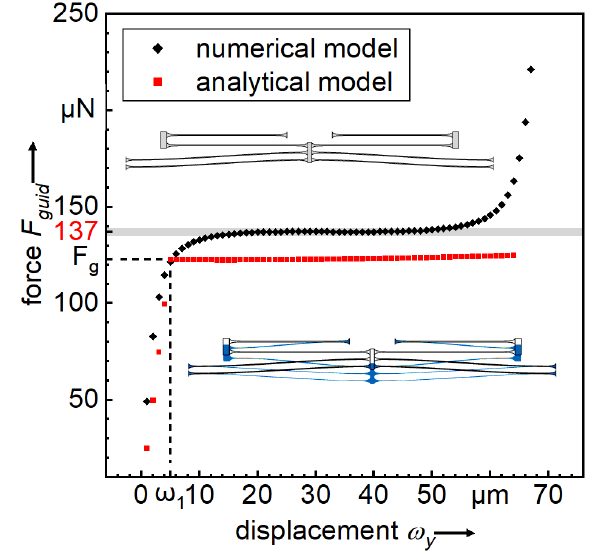
Figure 3. Simulation result of the constant force spring system consisting of one linear serpentine spring and two curved cosine-shaped buckling beams (shown above the graphs). The simulated maximal displaced spring system is pictured under the graphs. The following parameters were used for the analytical model: E [ 110 ] = 169GPa, k s,y ≈ 3 N , L c = 860 µ m, b c = 3.5 µ m, h ≈ 35 µ m, m t = 20 µ m, I z,c ≈ 71.5 µ m 4 . The simulated constant-force is F guid ≈ 137 ± 2 µ N between ω y = 13 µ m and 53 µ m, and the analytical force F g ≈ 123 µ N starts at ω 1 = 5 µ